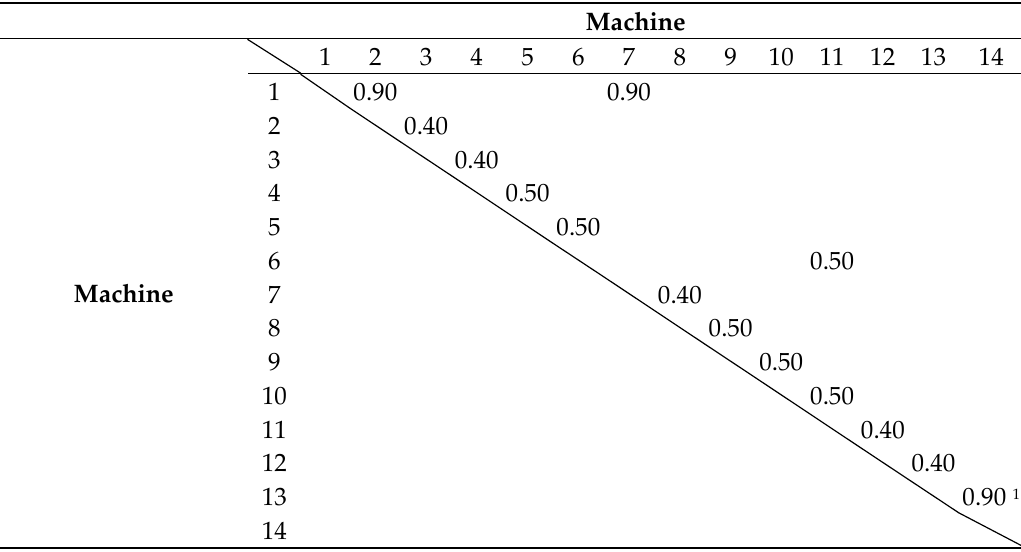
Table 5. Clearance matrix d ij for the analyzed case.